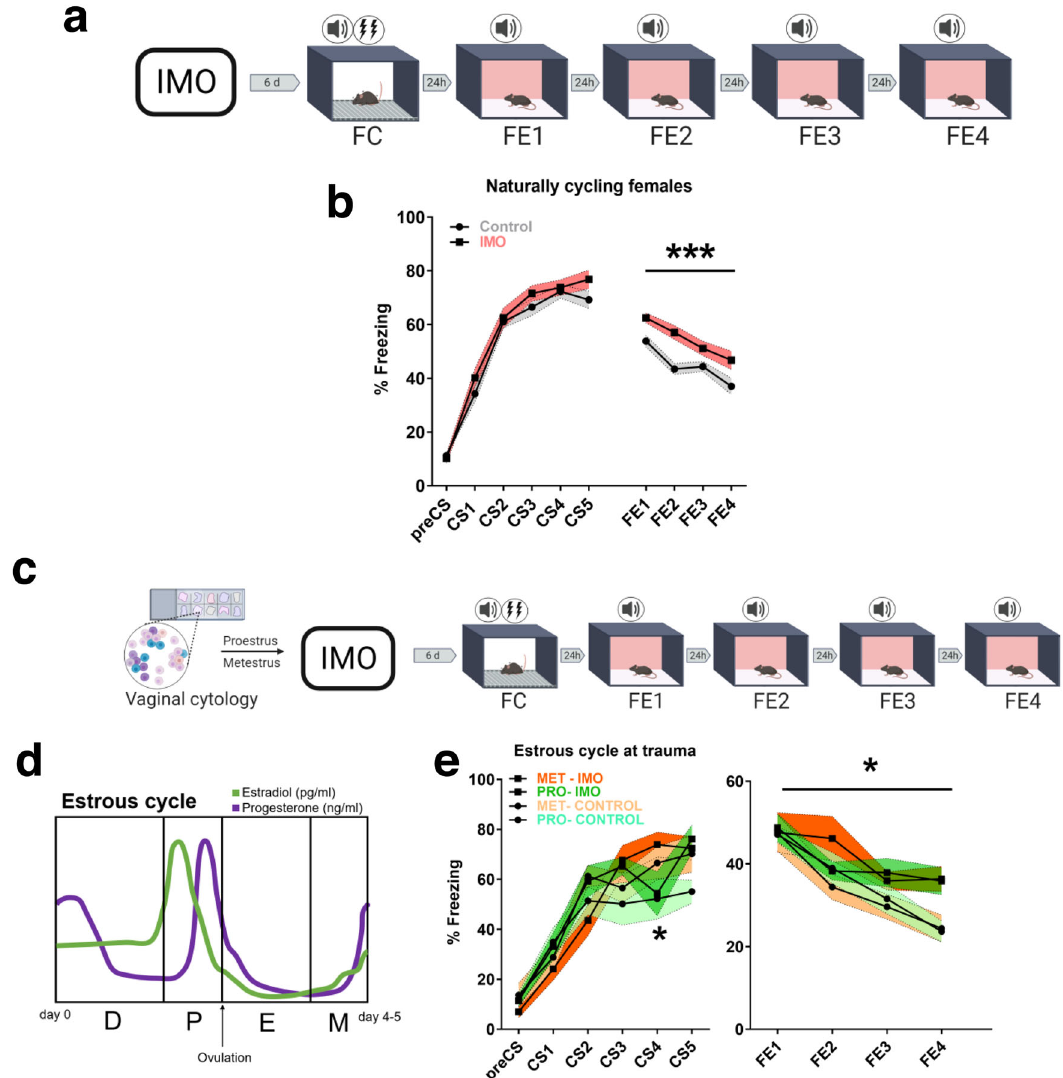
Fig. 1 Long-lasting alterations of behavior after trauma and its association with the estrous cycle phase. a Schematic representation of the behavioral protocol. b Fear learning and fear extinction in naturally cycling females undergoing IMO or compensatory handling (control: n = 31, IMO: n = 32) ( P = 0.001). c Methods used to monitor the estrous cycle before the behavioral procedures. d Estrous cycle and related hormonal levels in female C57BL/6 mice. e Fear learning, and fear extinction in proestrus or metestrus females ( n = 7 per group) ( P = 0.029). Data are expressed as mean ± SEM. * P ≤ 0.05, *** P ≤ 0.001. In b , e , main effect stress, main effect estrous cycle, main effect FE session or CS, and FE session* stress or CS*stress, estrous cycle*stress, FE session * estrous cycle, FE session * stress * estrous cycle interactions were analyzed using repeated-measures ANOVA, Bonferroni corrections were made for multiple comparisons. Asterisks above a line indicate signi fi cant main effect stress in repeated-measures ANOVA. CS conditioned stimulus, D diestrus, E estrus, FC fear conditioning, FE fear extinction session, IMO immobilization stress, M metestrus, Met metestrus, P proestrus, Pro proestrus. Source data are provided as a Source Data fi